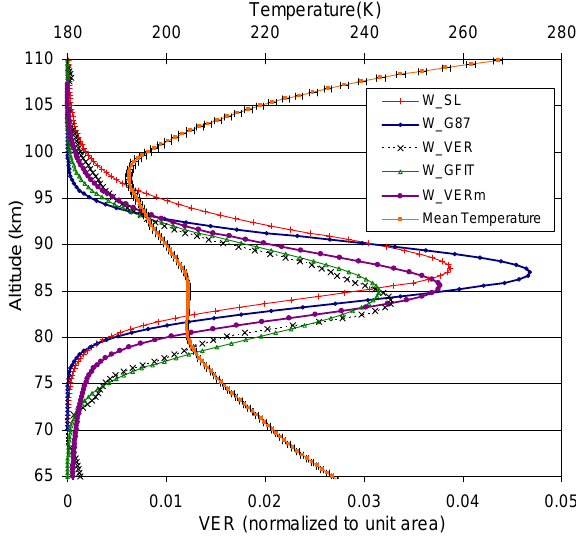
Figure 2. SABER weighting profiles considered in this study (see text for descriptions), 2 Fig. 2. SABER weighting profiles considered in this study (see compared with the mean (winter) mesopause temperature profile derived from the 2359 3 text for descriptions), compared with the mean winter mesopause SABER profiles within 500 km range. 4 temperature profile derived from the 2359 SABER profiles within 500km